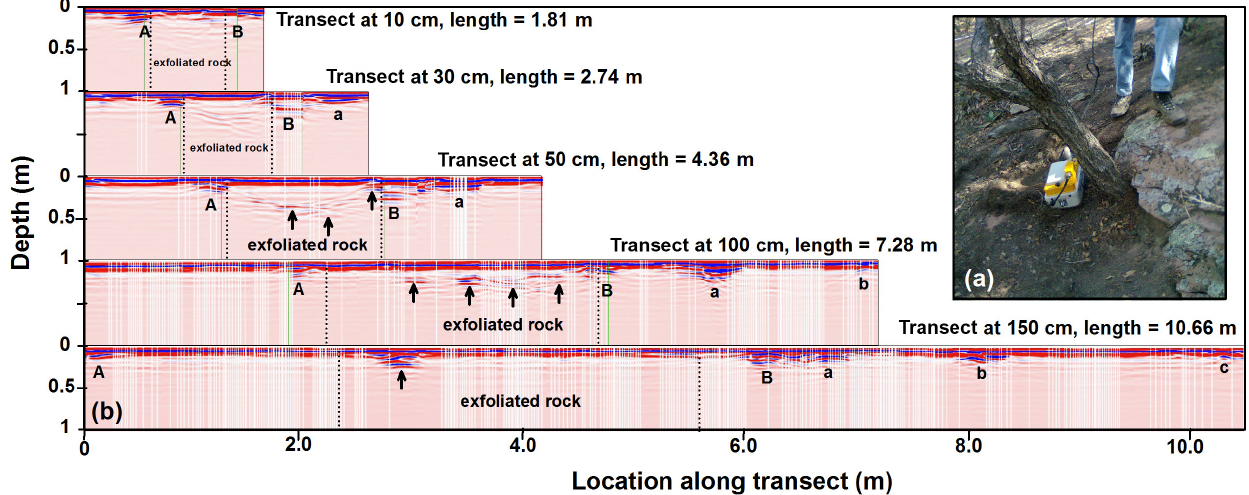
Figure 4. Concentric transects used to detect and track lateral root proliferation with GPR. (a) In situ photography showing a Pinus cem- broides root anchored in exfoliated rock and the GPR system with the 800MHz shielded antenna. Five concentric transects were established around the tree with 0.1, 0.3, 0.5, 1.0 and 1.5m distance between neighboring transects. The radius of each transect varied from 0.29 to 1.7m. (b) Corresponding GPR radargrams of different transect lengths. Same letters in different GPR radargrams indicate examples of reflections from the same roots; uppercase letters indicate roots used for calibration. Arrows indicate root presence under exfoliated rocks.